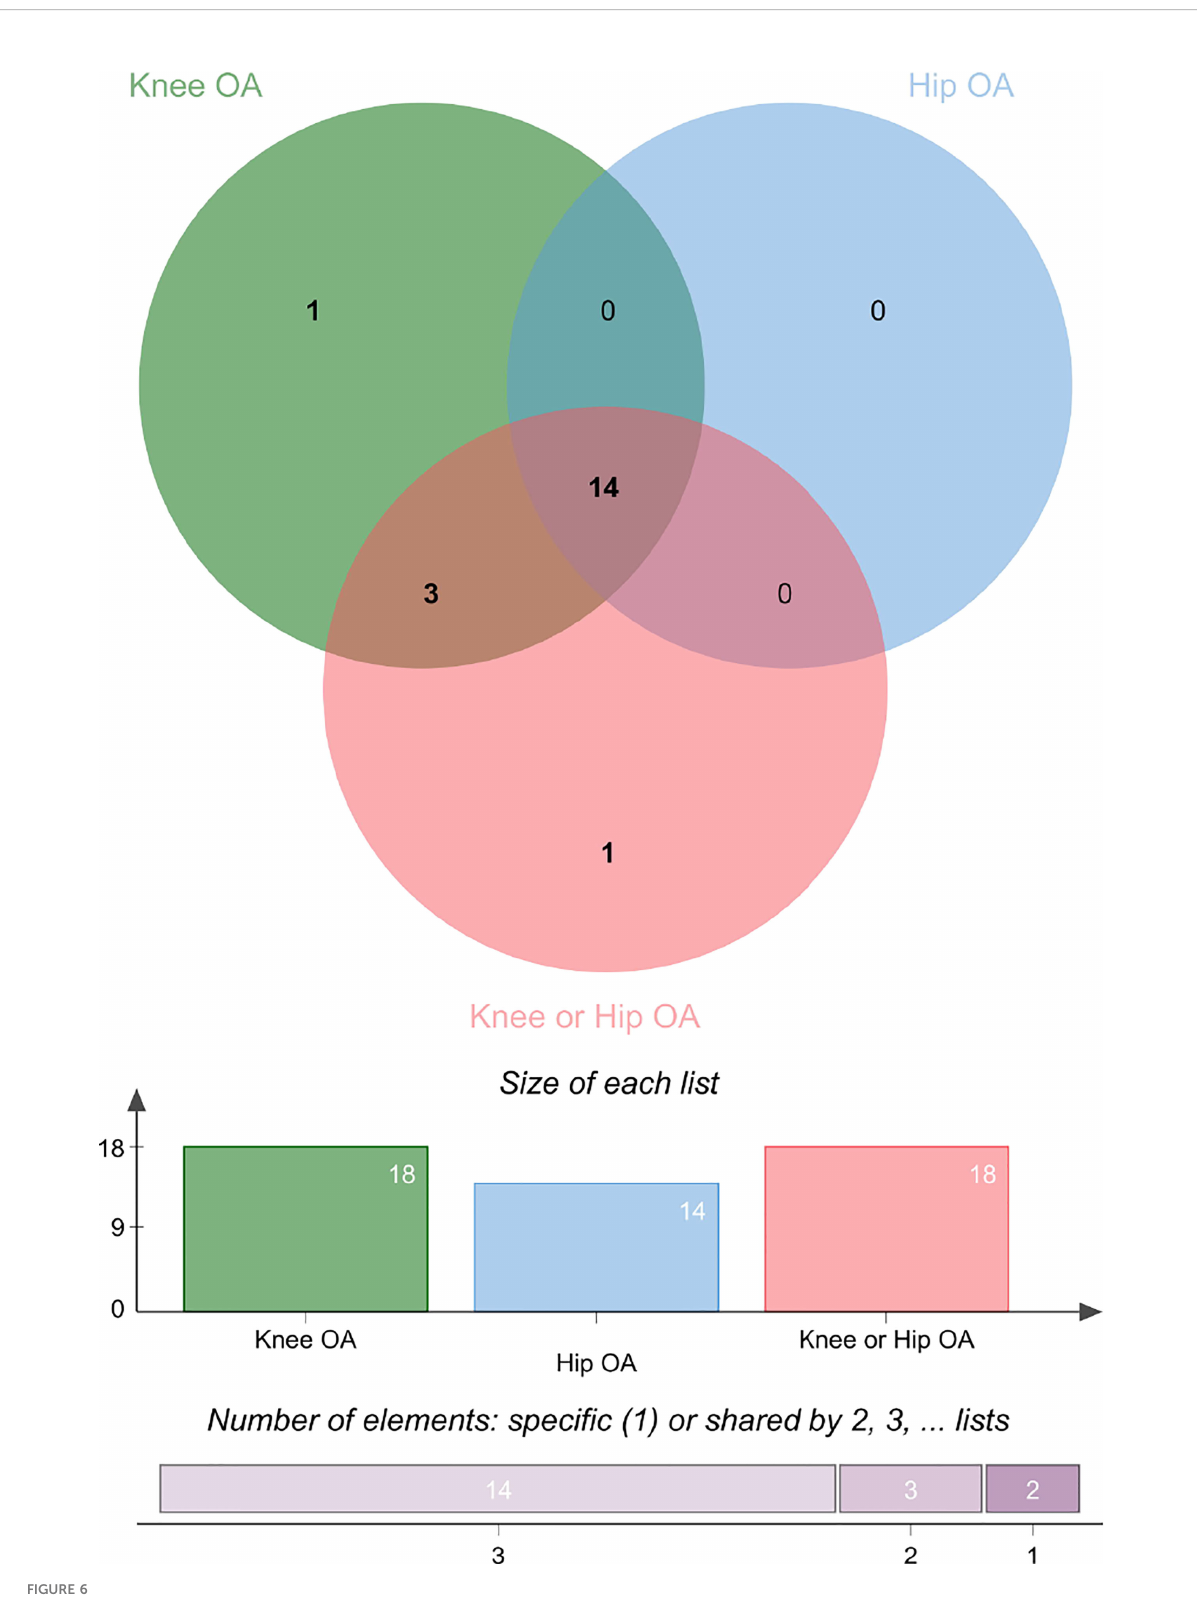
FIGURE 6 The Venn diagram of the univariable MR on knee and hip OA. See also Table